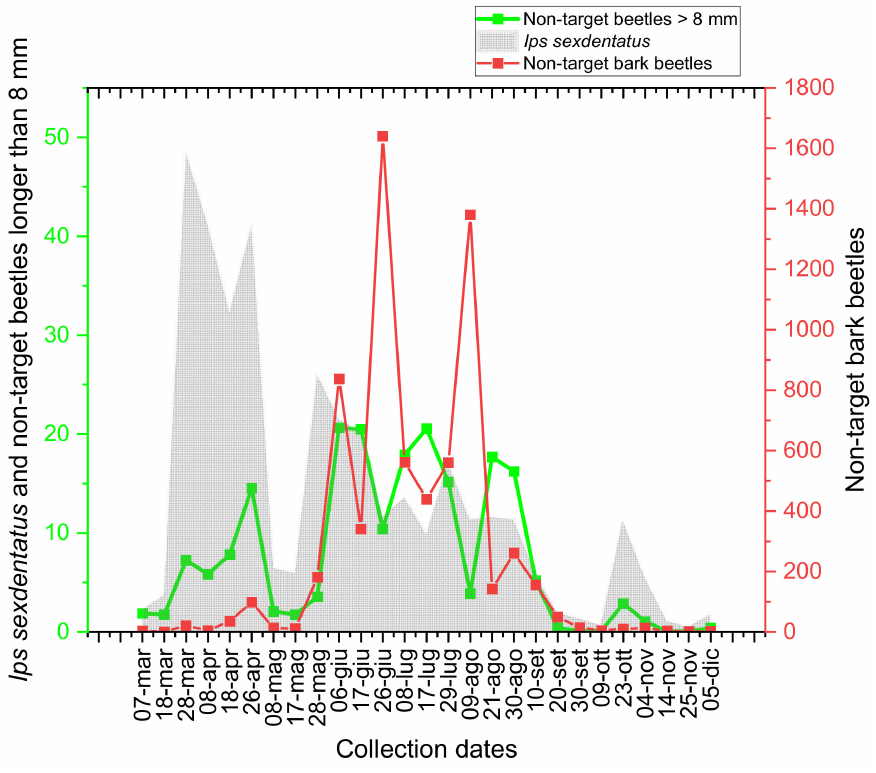
Figure 4. Mean number (standard and modified traps together) of trapped adults of Ips sexdentatus , non-target bark beetles, and non-target beetles > 8 mm in the study site (Municipality of Grosseto, Tuscany, Italy) during 2019.